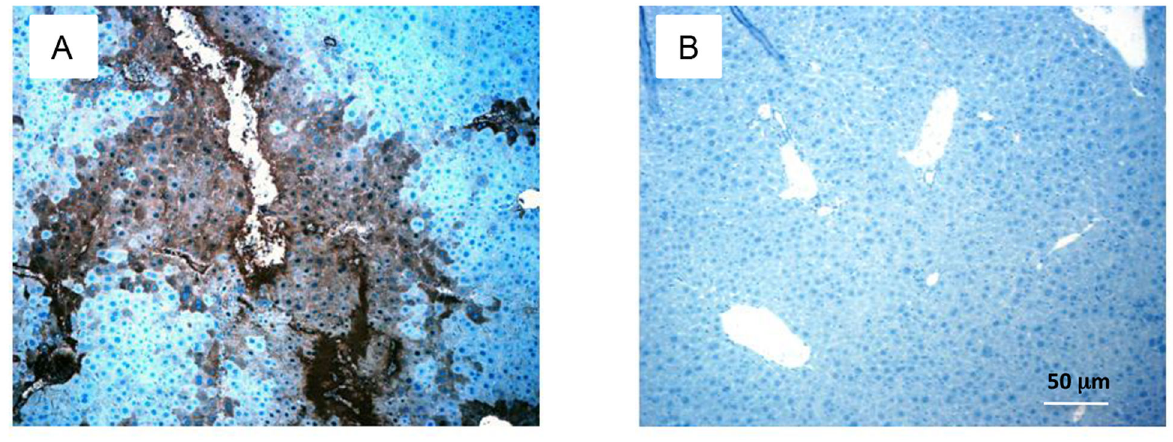
Figure 3. Engraftment of primary human hepatocytes into necrotic liver of MUP-uPA/SCID/Bg mice. A . Human hepatocytes are identified within the parenchyma of a chimeric mouse that had been engrafted with human hepatocytes at age 27 weeks and euthanized 10 weeks later. Staining was done with HRP-conjugated anti-human albumin (brown-black) and counter stained with hemotoxylin (blue). B . Section of liver from a control unengrafted transgenic mouse stained with similar HRP-conjugated anti- human albumin. doi: 10.1371/journal.pone.0077298.g003 To test for the sensitivity to infection with HCV in the chimeric intravenously (i.v.) a ten-fold dilution series of HCV (strain H) mice relative to the infectivity in chimpanzees , we inoculated plasma containing a beginning titer of 10 4.5 50% chimpanzee